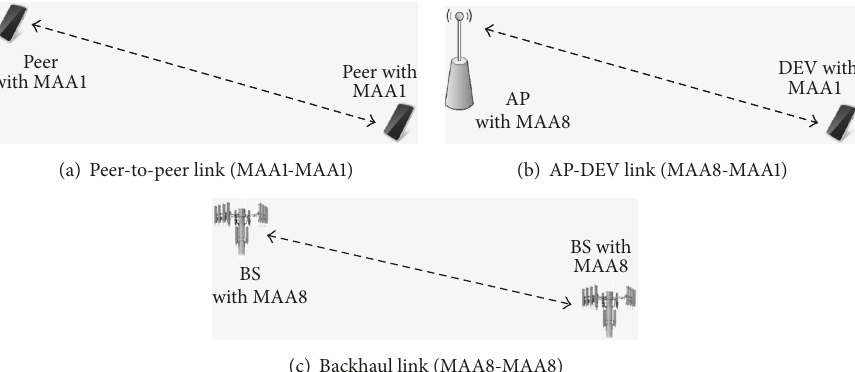
Figure 6: Link budget analysis scenarios with MAA.